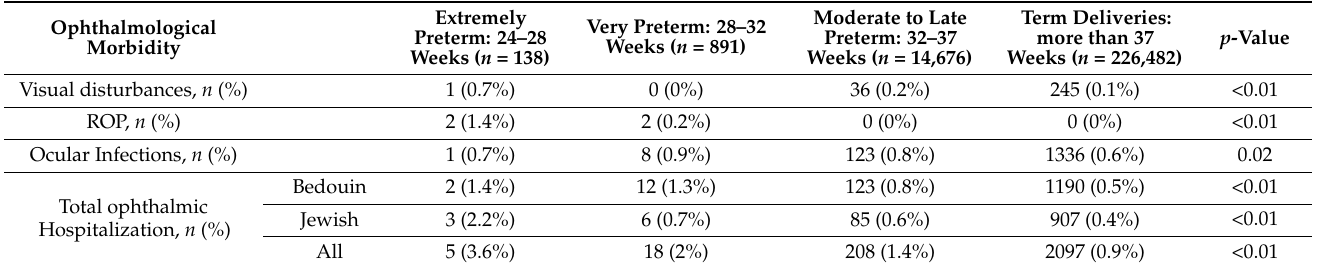
Table 3. Selected long-term ophthalmological morbidities for children (age < 18) by delivery week.